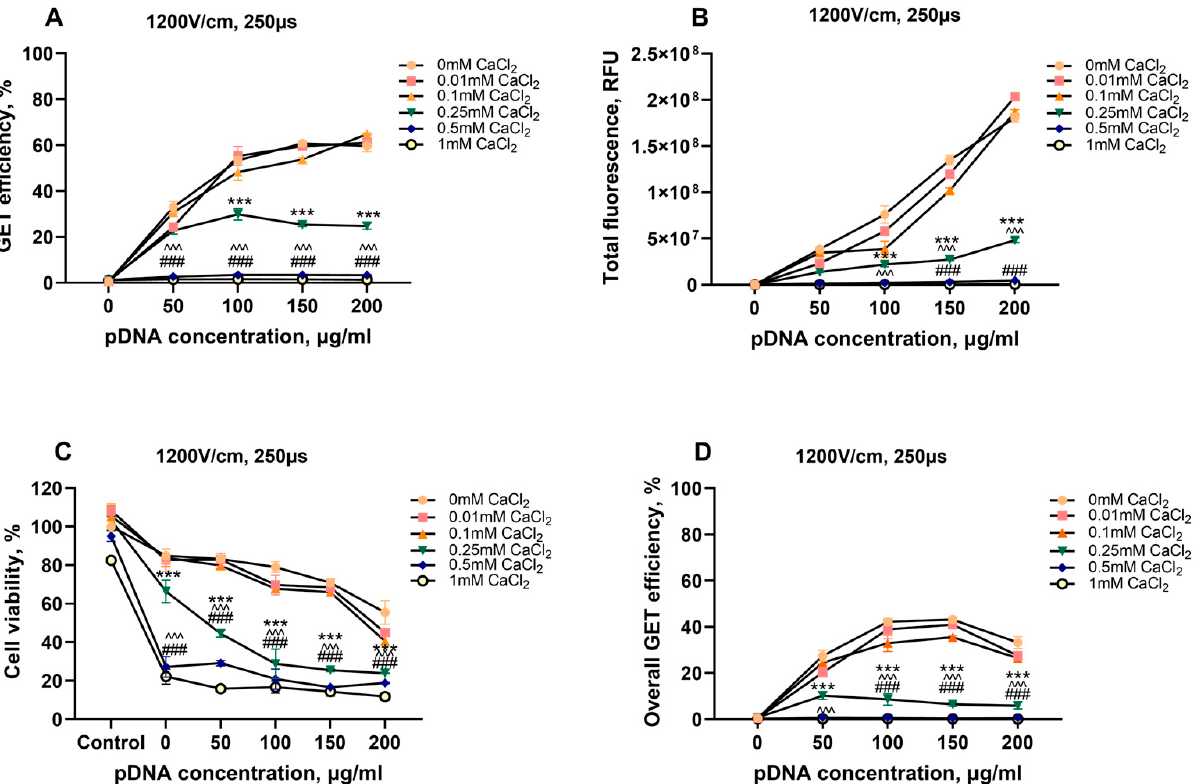
Figure 6. The dependence of pDNA electrotransfer efficiency ( A ), GFP total fluorescence intensity ( B ), cell viability ( C ), and normalized electrotransfer efficiency ( D ) on pDNA and CaCl 2 concentrations in the electroporation medium. Cells were treated using one square pulse of 1200 V/cm for 250 µ s. Results were evaluated 24 h after electroporation. Error bars represent the standard error of the mean (SEM) of n = 9 experimental replicates. In case standard errors were lower than actual data points, error bars are not visible. The statistical differences between the control (0 mM) and the 0.25, 0.5, and 1 mM CaCl 2 at different pDNA concentrations used are denoted by ***, ###, and ˆˆˆ, respectively; three symbols denote p < 0.001.